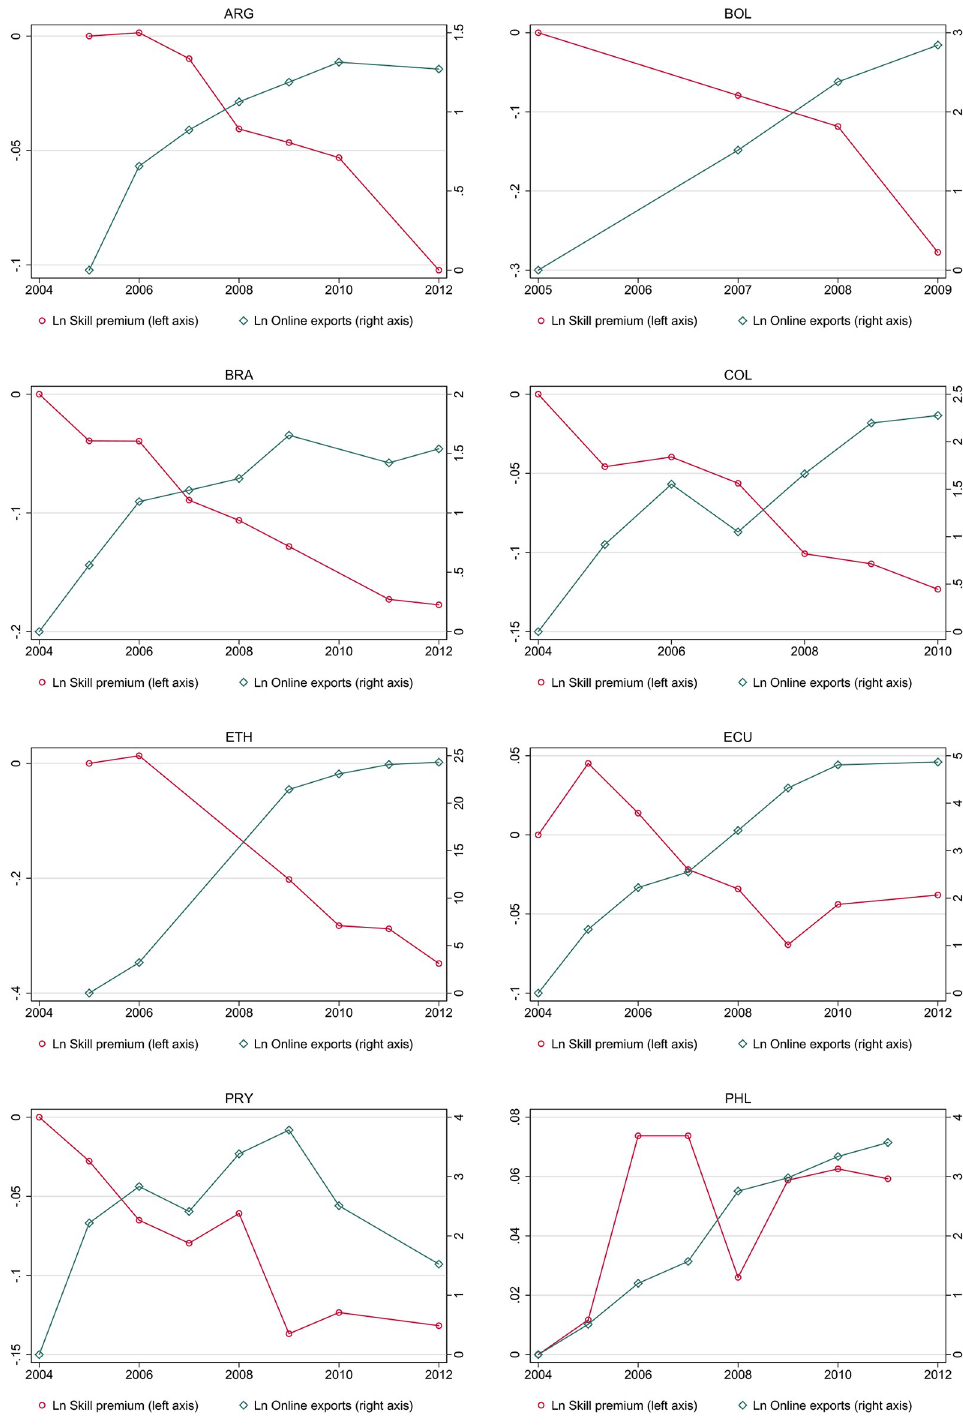
Fig 3. Wage gap in selected countries.